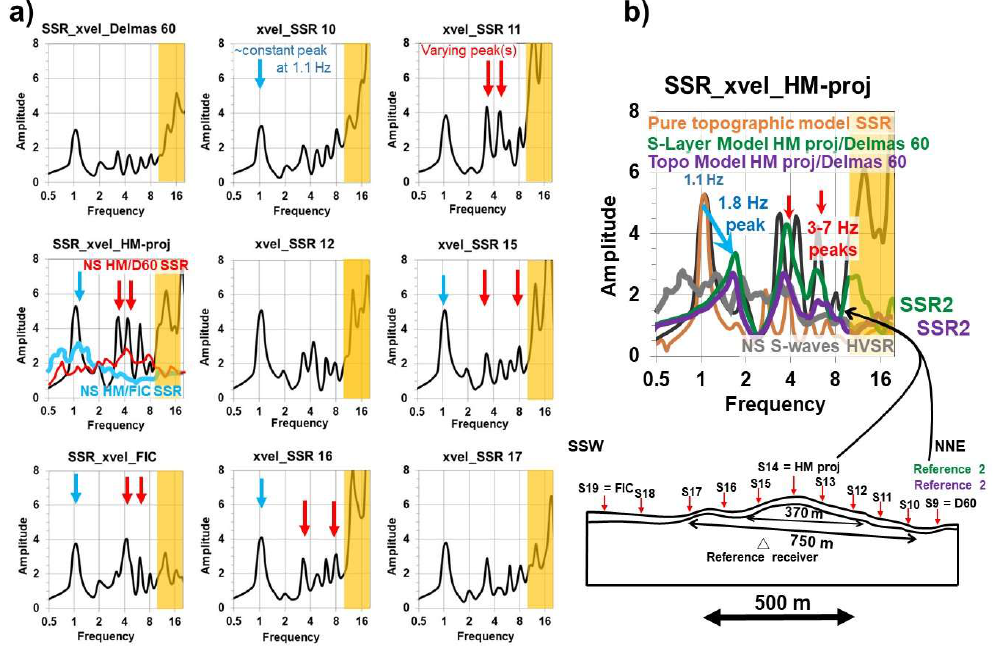
Figure 8. ( a ) SSR graphs for several surface receivers distributed along the 2D numerical section. For the equivalent HM site, the modelled SSR is compared with the measured NS SSR obtained with respect to the FIC (in blue) and with the Delmas 60 station (in red). The first and second amplification peaks are marked, respectively, by a blue and by two red arrows. ( b ) The modelled equivalent HM SSR (black curve) is compared with the measured NS S-waves HVSR of HM site (grey curve) and the SSR result (beige) from a purely topographic model (surface layer with identical properties as bedrock). The green and violet curves represent the SSRs of the equivalent HM site with respect to surface Reference 2 receiver S9 = Delmas 60, in the surface layer model (marked in green), and the purely topographic model (marked in violet), respectively. See blue arrow marking the shift of the first peak and the red arrows indicating the second layer peaks. See also parts of spectrum with low energy content in the input signal (not used for analysis) marked by an orange semi-transparent mask.